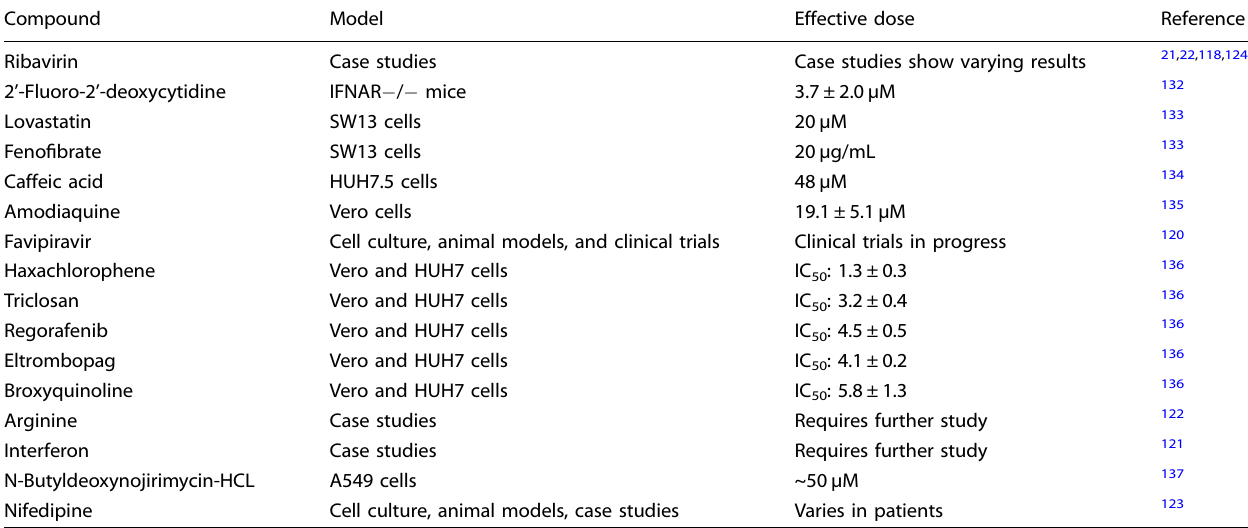
Table 2. Compounds that have been shown to inhibit SFTSV infection a .